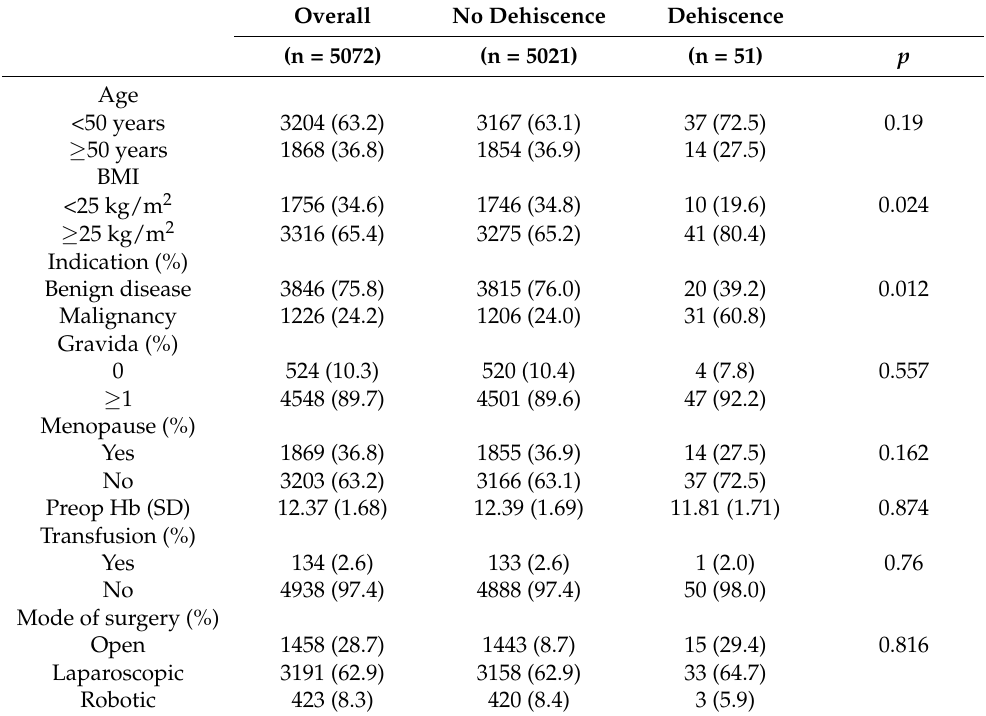
Table 2. Patient characteristics of the study population according to the presence of vaginal cuff